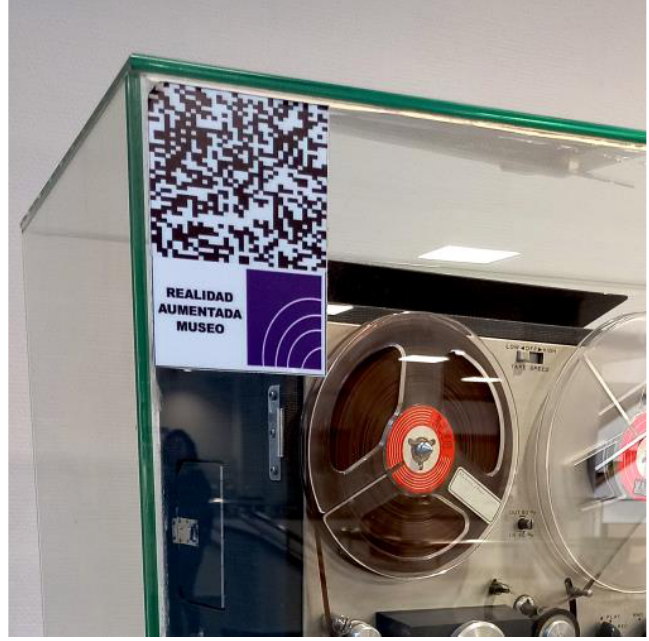
Figure 1. AR target of the 1964 Akai magnetophone.